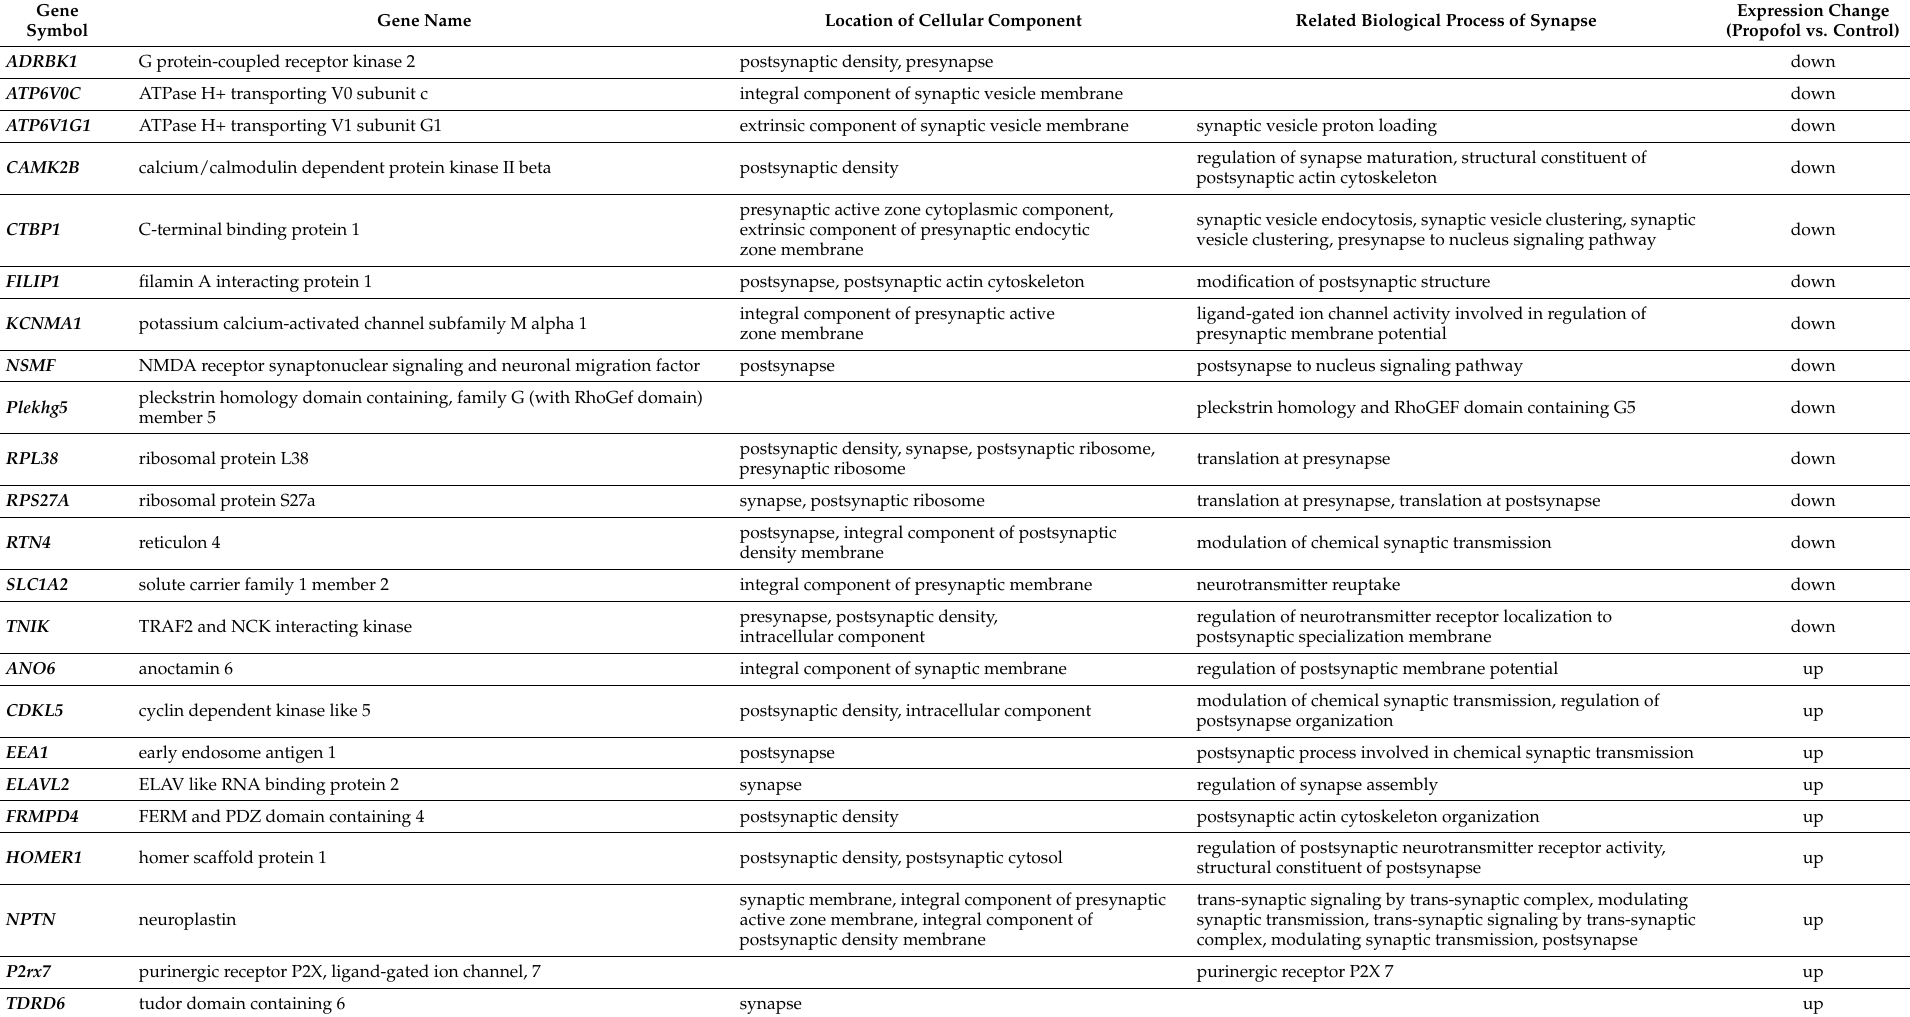
Table 1. The cellular location and functions of propofol-induced dysregulated synaptic